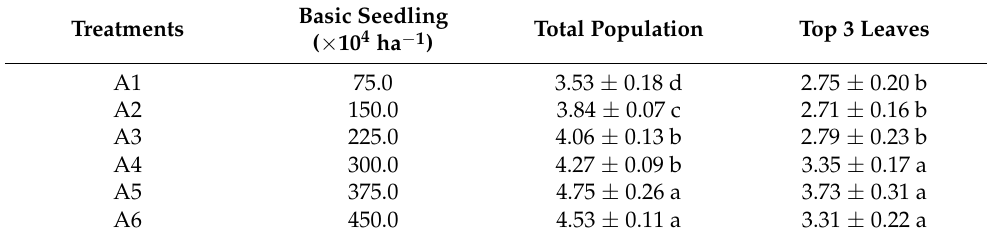
Table 1. Composition of LAI at anthesis in different densities.